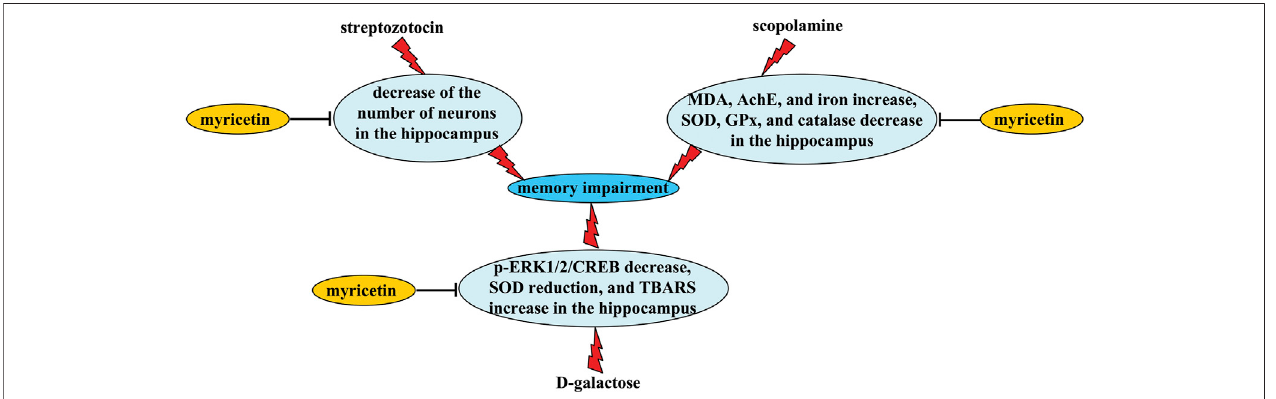
FIGURE 3 | Neuroprotective effects and possible mechanisms of myricetin in Alzheimer ’ s disease-associated models. Myricetin administration can suppress (i) streptozotocin-induced memory impairment via inhibiting streptozotocin-induced decrease in neuronal numbers in the hippocampus, (ii) D-galactose-induced memory impairment via inhibiting scopolamine-induced increase in MDA levels and iron contents and decrease in SOD, GPx, and catalase activities in the hippocampus, and (iii) D-galactose-inducedmemoryimpairmentviainhibitingD-galactose-induceddecreaseinthephospho-ERK1/2and-CREB,decreaseinSODactivity,andincrease in TBARS levels in the